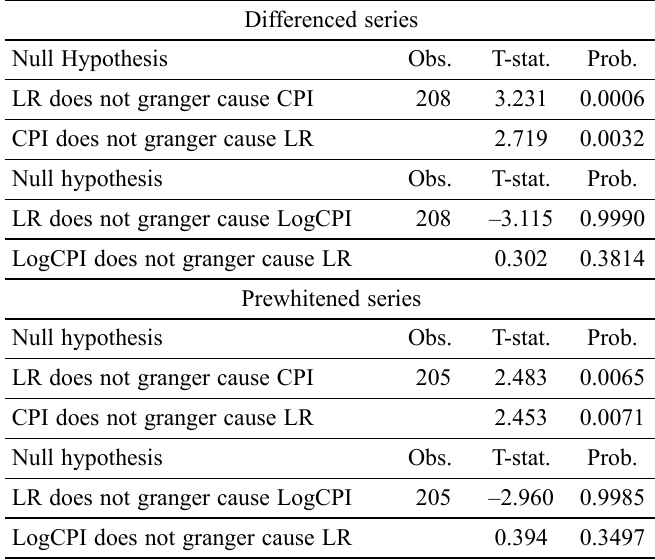
Table 8 . Nonlinear granger causality